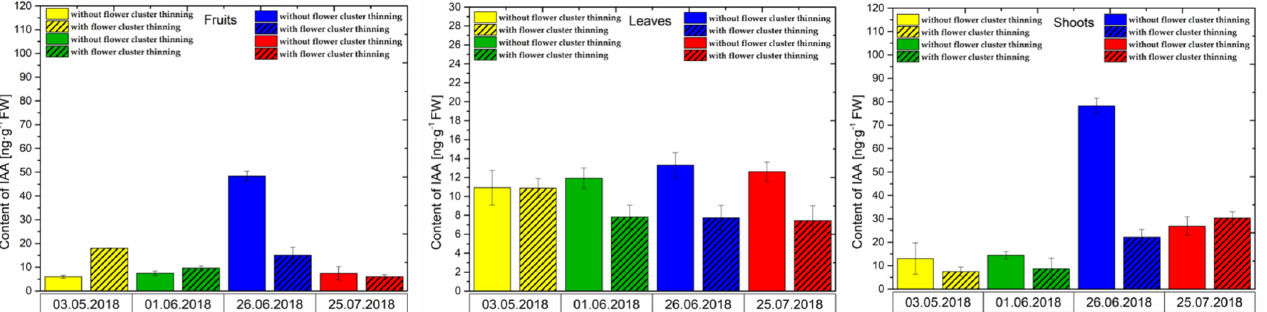
Figure 4. Concentration of IAA in Organs of Pistachio Trees With or Without Flower Cluster Thinning Application.